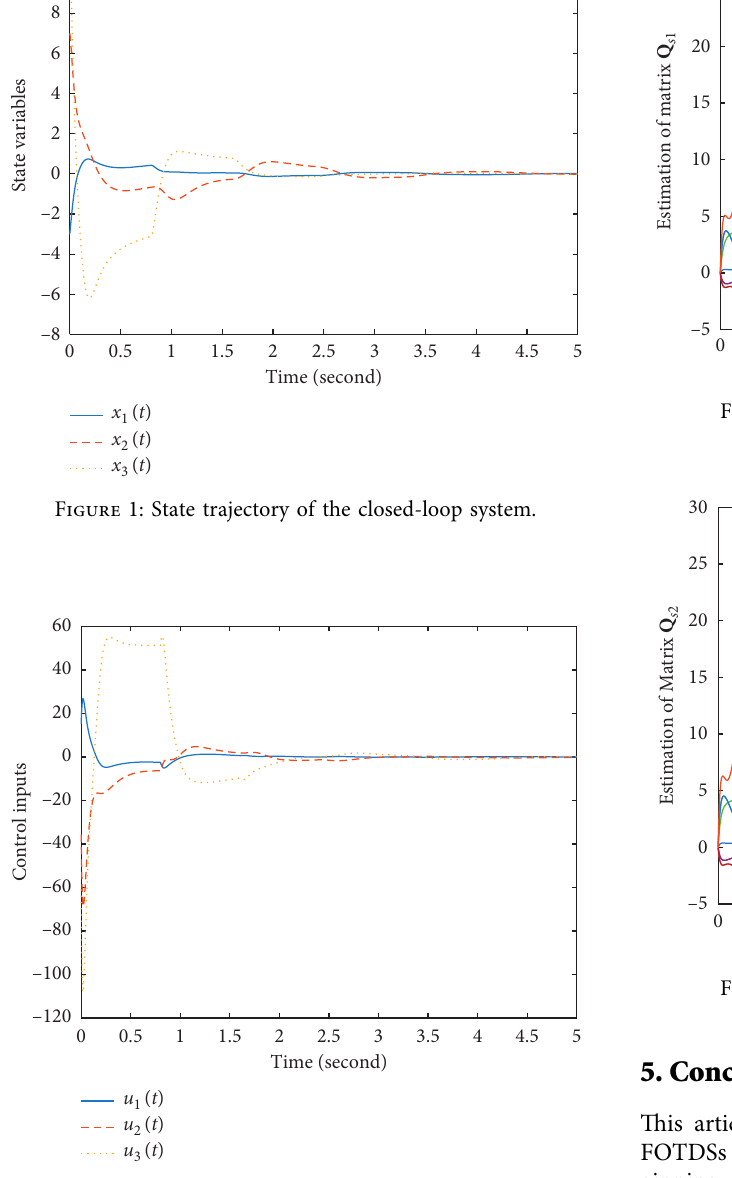
Figure 2: The control inputs of the close-loop system.